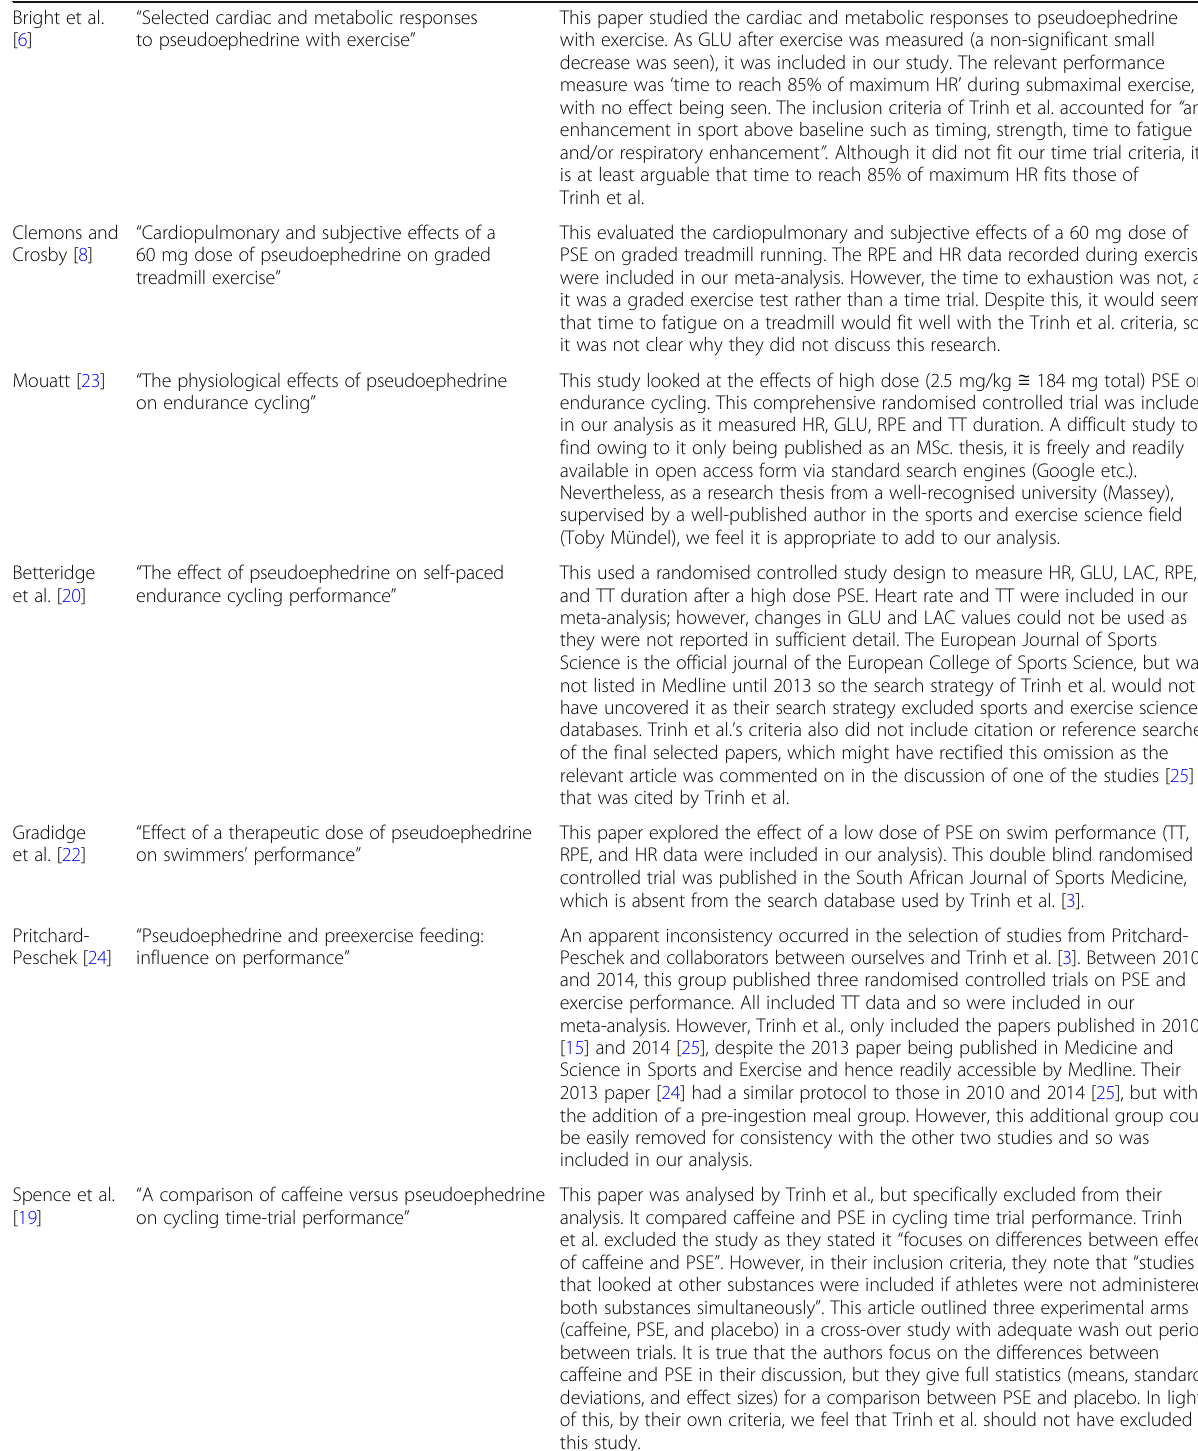
Table 4 Characteristics of studies included in this meta-analysis that were not included in Trinh et al. [3] systematic